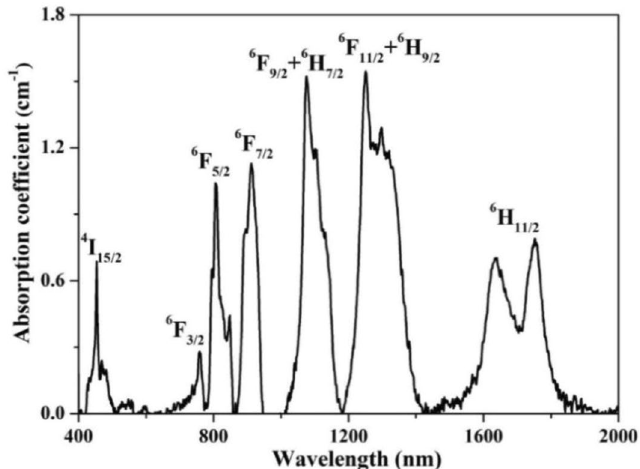
Figure 4. Absorption spectrum of Dy: CYA